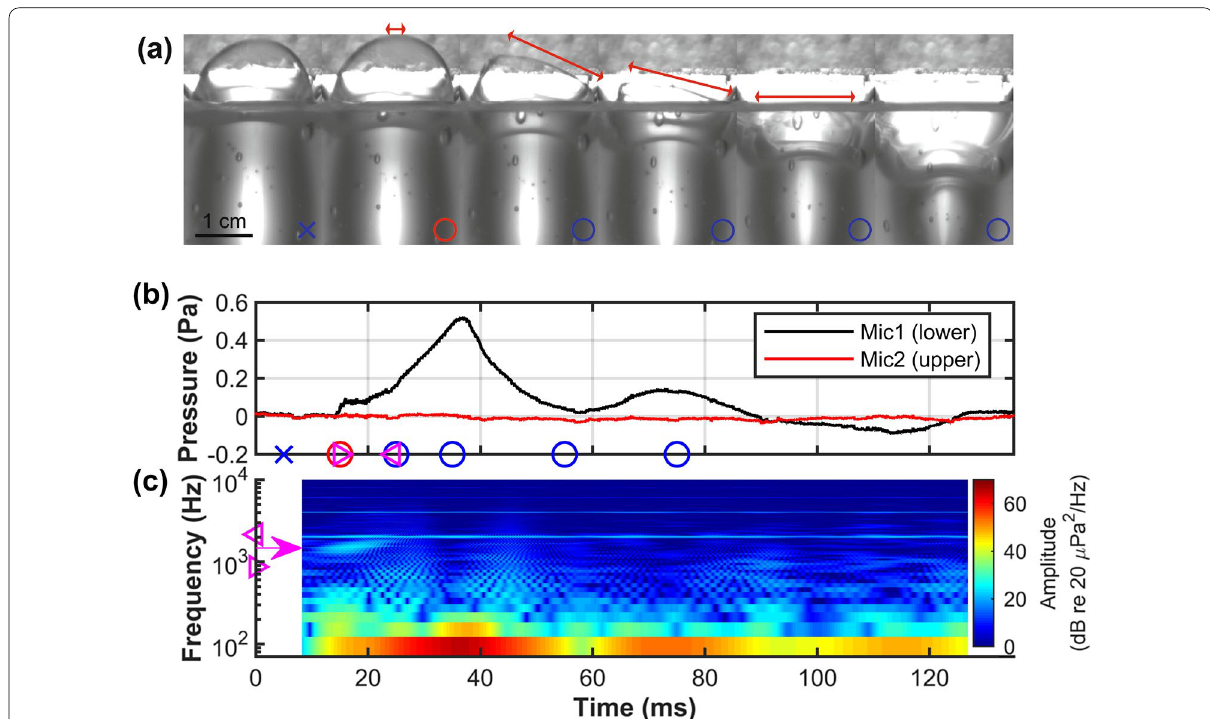
Fig. 9 An example of an air flow (case 6a). V = 12 cm 3 bubble bursts while it is rising in a suspension of φ = 0.4 . a Time-lapse images (see Additional file 5: Movie 5). b Waveform (raw data) of the airwave recorded by 2 microphones. × and (cid:31) correspond to the times indicated in ( a ). The pink ⊲ and ⊳ indicate the times when the aperture radius R a was measured. c Spectrogram (time window 16.384 ms, overlap 16.3 ms) of Mic 1 (lower) data shown in ( b ). ⊲ and ⊳ indicate f H = 870 and 2161 Hz, calculated from Eq. (11) using R a measured at the respective times shown in ( b ). The pink arrow indicates the Helmholtz resonance excited after